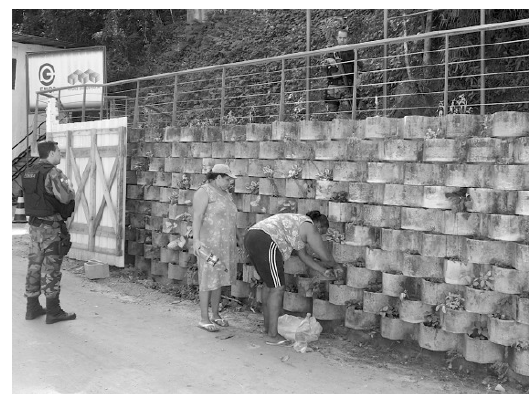
Figure 10. Planting a vertical garden with residents near the entrance to Rocinha’s ecopark as UPP officers look on during their patrol.